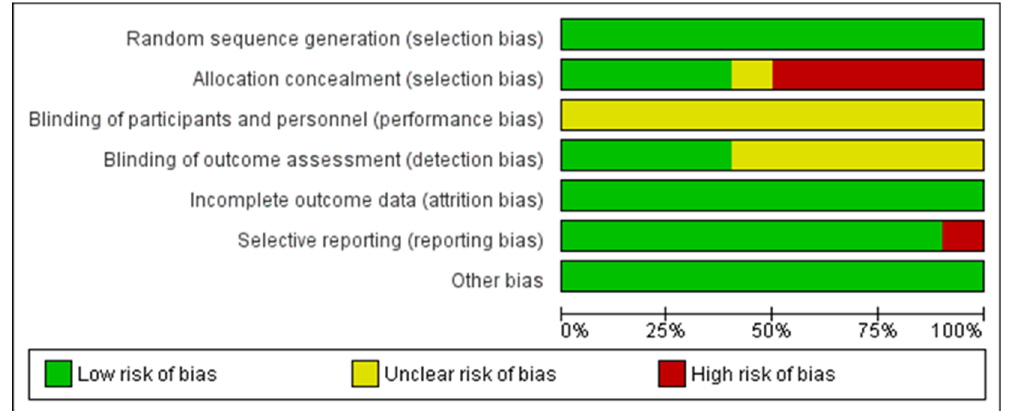
Figure 2. Risk of bias graph: authors’ assessment of each item expressed as a percentage for all included studies.